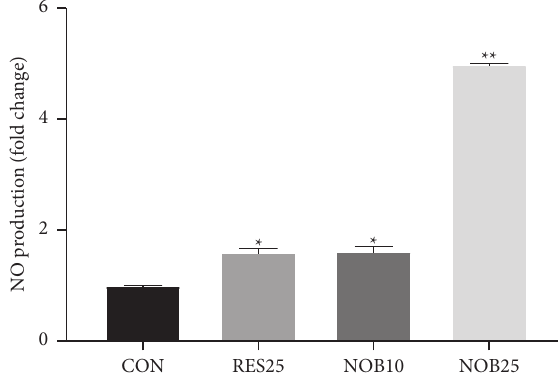
Figure 2: Dose-dependent effect of nobiletin to increase NO production using the DAF-2 assay. Effect of increasing DAF-2 detected NO release from EA.hy926 cells after 18h incubation with nobiletin (NOB) at 10–25 μ M and resveratrol (RES; 25 μ M) as a positive control. Data were expressed as a fold change of control. Data are presented as mean ± SD. ∗ and ∗∗ indicate significant differences between the treatment group and untreated control group at p < 0 . 05 and p < 0 . 01, respectively. CON: